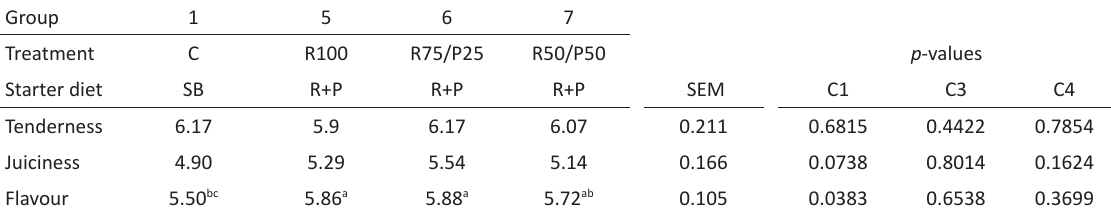
Table 9. Mean sensory quality of broiler breast muscle in response to diets with soybean (SB) meal, rapeseed meal (R), or rapeseed